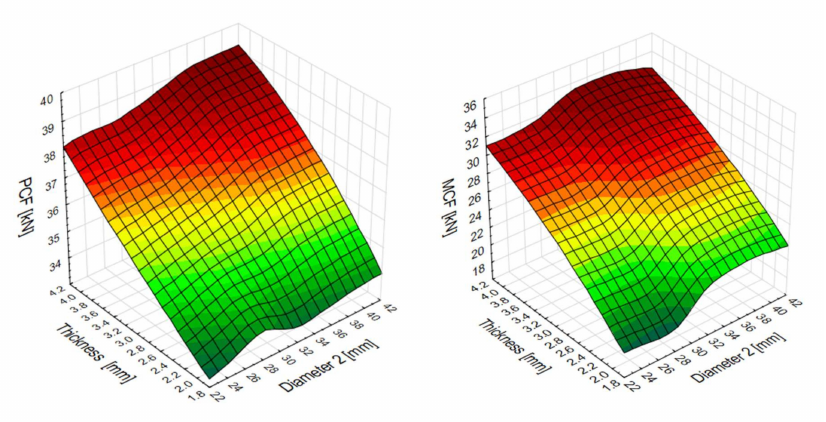
Figure 12. Peak crushing force (PCF) and mean crushing force (MCF) surface